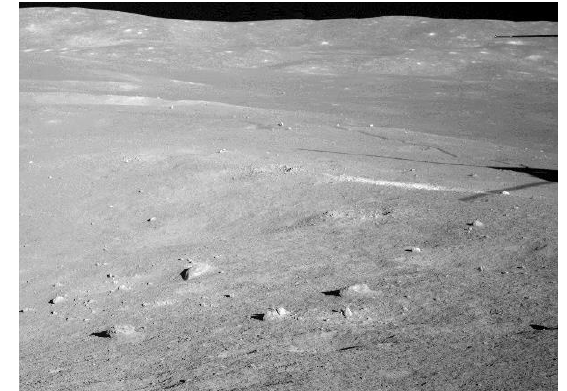
Figure 11. A Pancam image showing several rocks on the wall of the crater to the north of the lander.